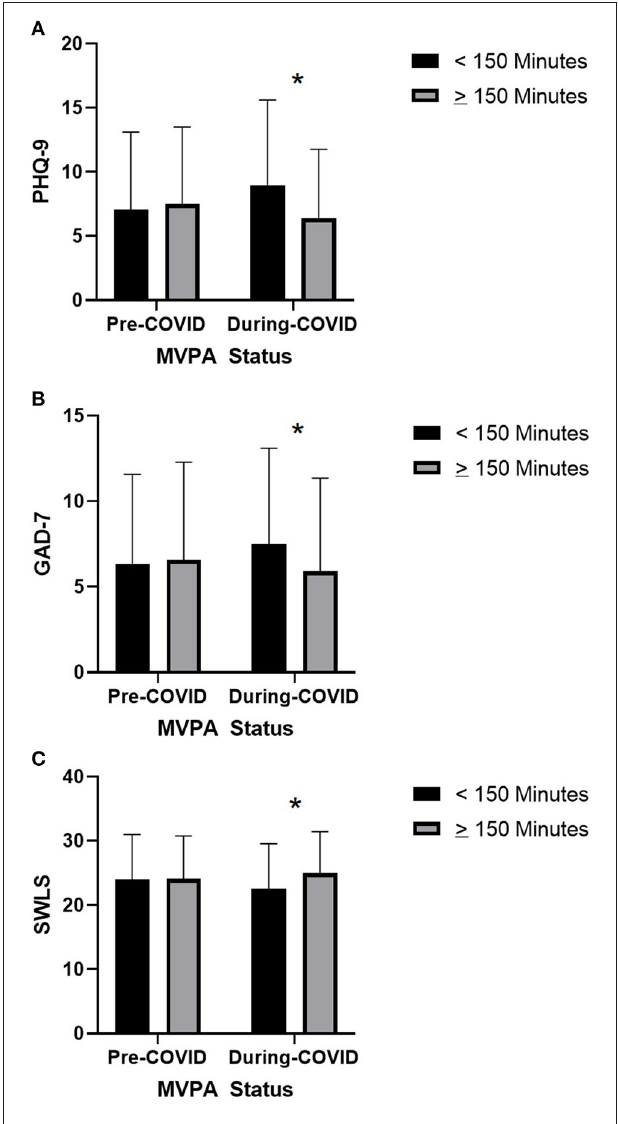
FIGURE 2 | Associations between pre- and during-COVID MVPA status and mental health symptoms. (A) Associations between pre- and during-COVID MVPA status and during-COVID depressive symptoms. (B) Associations between pre- and during-COVID MVPA status and during-COVID anxiety symptoms. (C) Associations between pre- and during-COVID MVPA status and during-COVID life satisfaction. *Significant with Bonferroni